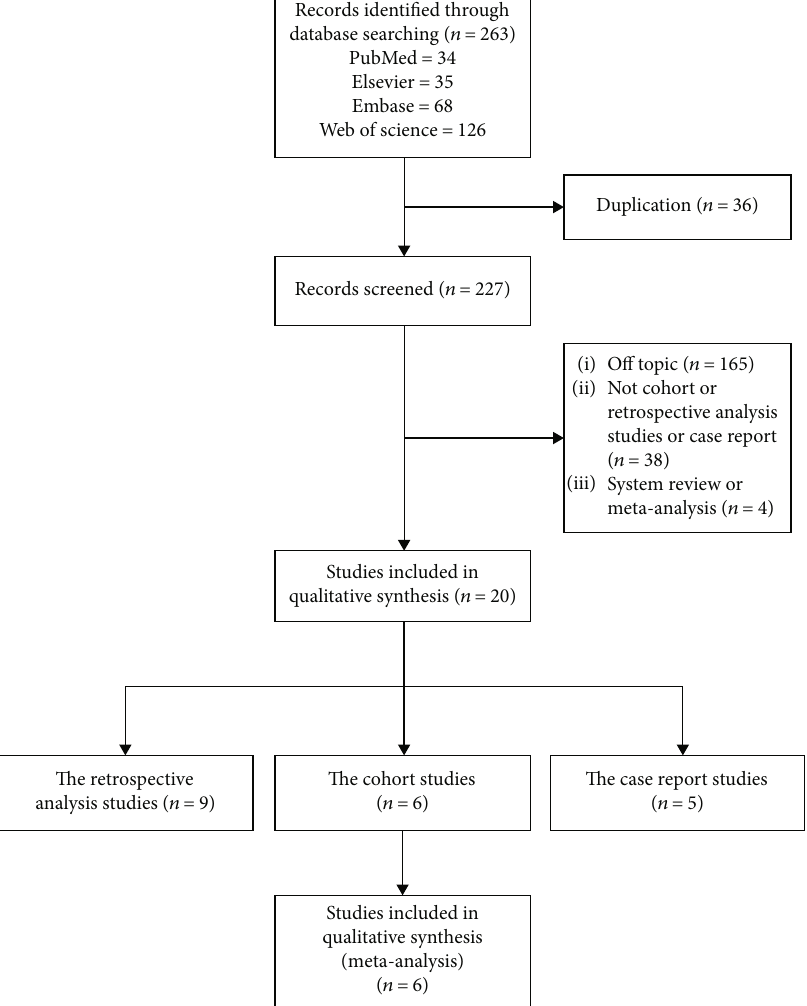
Figure 1: Flow diagram representing the selection